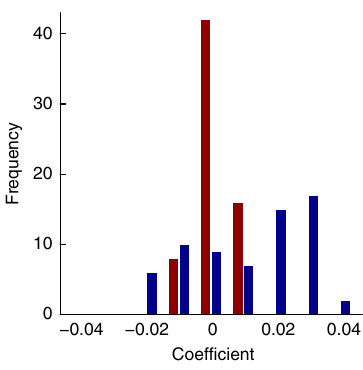
Fig. 6 Relationship between evolutionary distance and interspeci fi c δ 18 O and δ 13 C offsets. We repeated the process outlined in Fig. 5 for each of the other 65 Cenozoic macroperforate species in the data set. Subsequently the co-ef fi cient of the regression slope between the evolutionary distance and each of the model-averaged species-speci fi c δ 18 O and δ 13 C offsets relative to the other 65 taxa in the data set are presented here. Blue bars are for δ 13 C and red bars are for δ 18 O. Note that regression slopes are more positive for δ 13 C than for δ 18 O, indicating that closely related species are likely to have more similar isotopic offsets than more distantly related ones supporting a role for evolutionary history in shaping δ 13 C but not δ 18 O